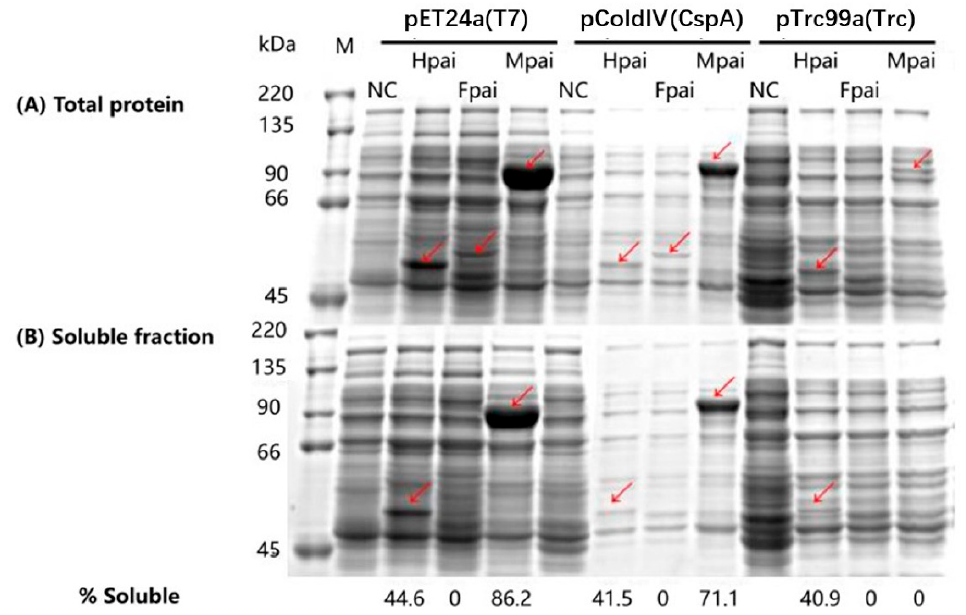
Figure 3. Effects of promoters and fusion tags on total ( A ) and soluble ( B ) expression of PAI, analyzed using SDS-PAGE. Lanes (from left to right): marker, pET24a, T7 + His6, T7 + Fh8, T7 + MBP, pColdIV, CspA + His6, CspA + Fh8, CspA + MBP, pTrc99a, Trc + His6, Trc + Fh8, Trc + MBP. Arrows indicate recombinant PAI protein.